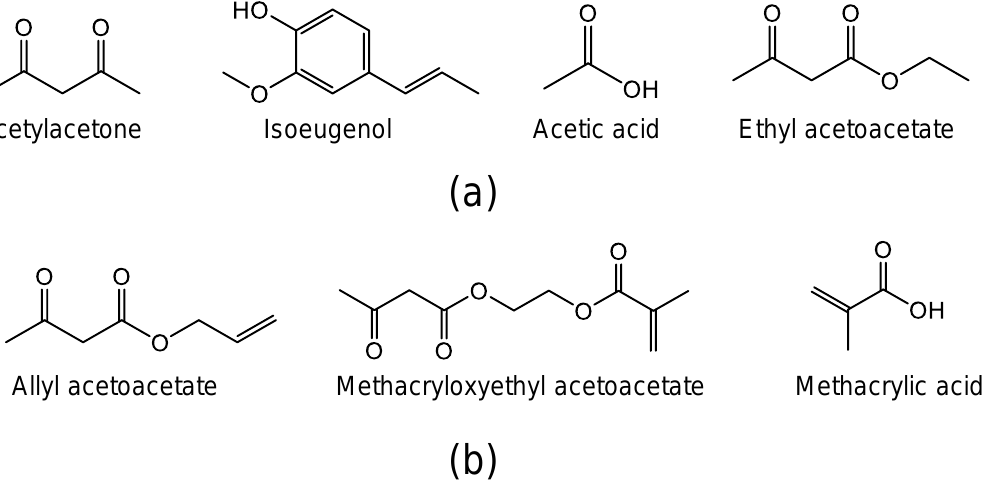
Figure 8. Some organic coordination/chelating ligands: ( a ) network modifiers; ( b ) network formers.